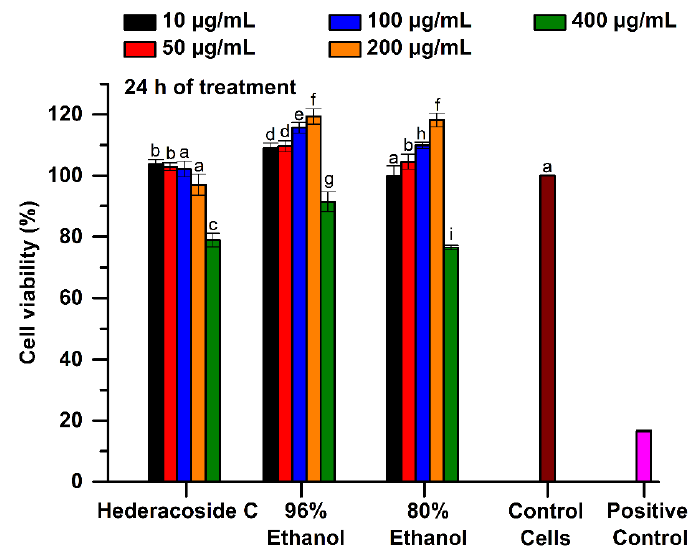
Figure 6. Cell viability of L929 fibroblasts cultured in the presence of 96% and 80% ethanolic Hedera helix extracts and hederacoside C as saponin standard, assessed by MTT assay, at 24 h of treatment. Untreated cells in the culture medium and the cells cultivated in the presence of 0.003% H 2 O 2 were used as controls. Different letters (a–i) shows the significant difference between samples (ANOVA, p < 0.05).